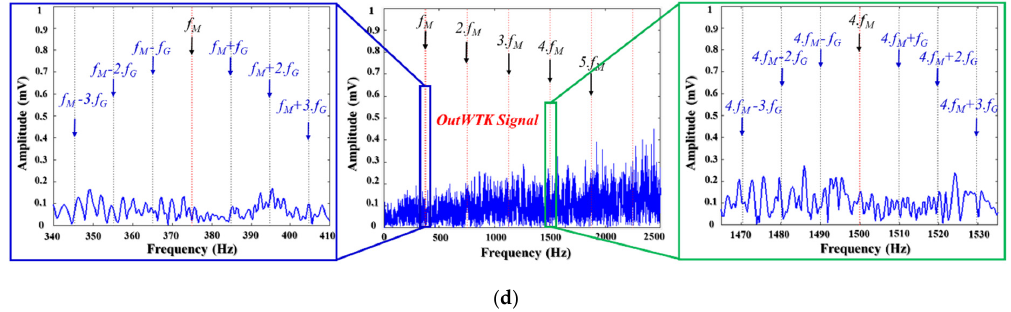
Figure 12. The frequency spectrum analysis for the state-of-the-art methodologies: ( a ) the input signal, ( b ) the output signal from the Hilbert transform module, ( c ) the output signal from the window bandpass filter module, and ( d ) the output signal from the wavelet transform WTK module.